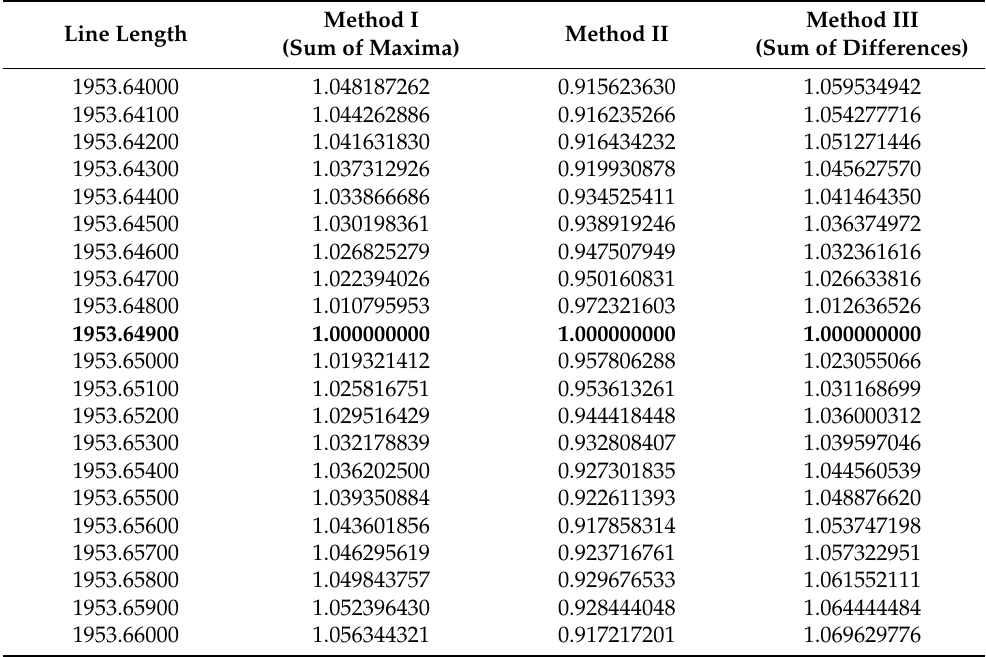
Table 6. Image line length estimation results for the accuracy ∆ =